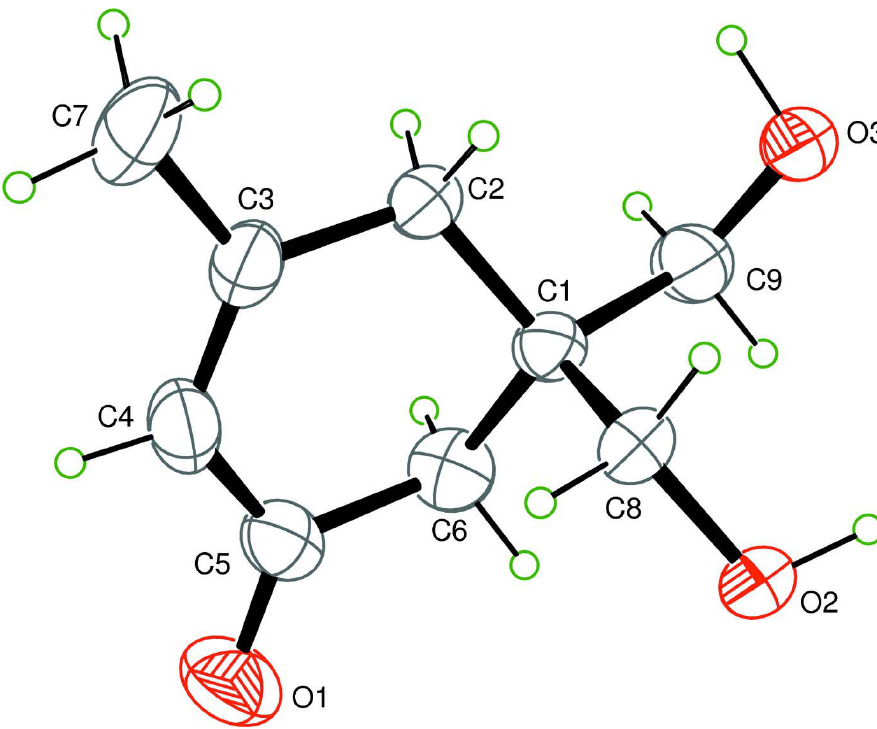
Figure 1 The unit of (I) with atom labels, showing 50% probability displacement ellipsoids.